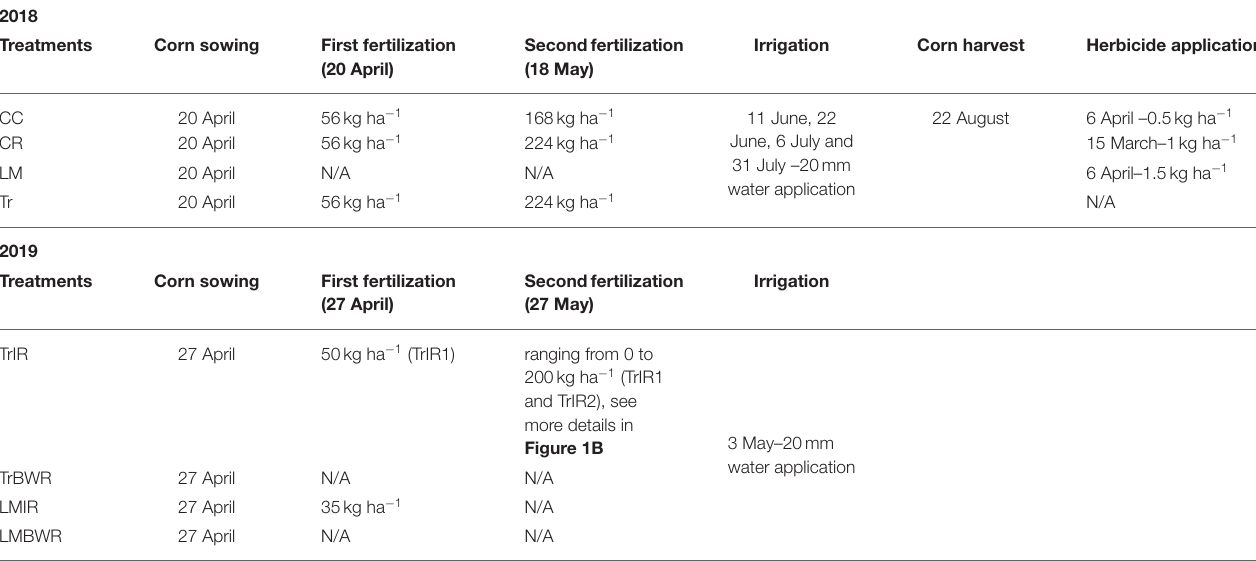
TABLE 1 | Field events